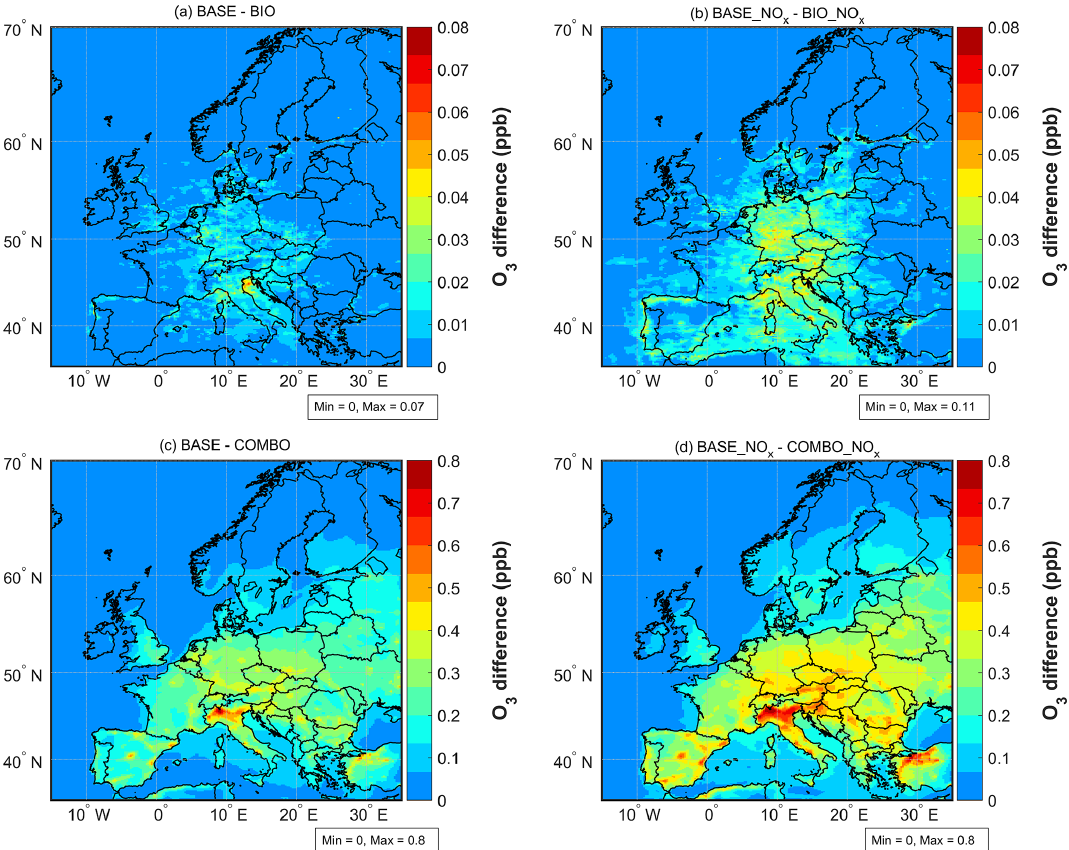
Figure 10. Seasonal daytime (10:00–18:00LMT) mean O 3 differences between the (a) BASE and BIO, (b) BASE_NO x and BIO_NO x , (c) BASE and COMBO, and (d) BASE_NO x and COMBO_NO x scenarios in summer